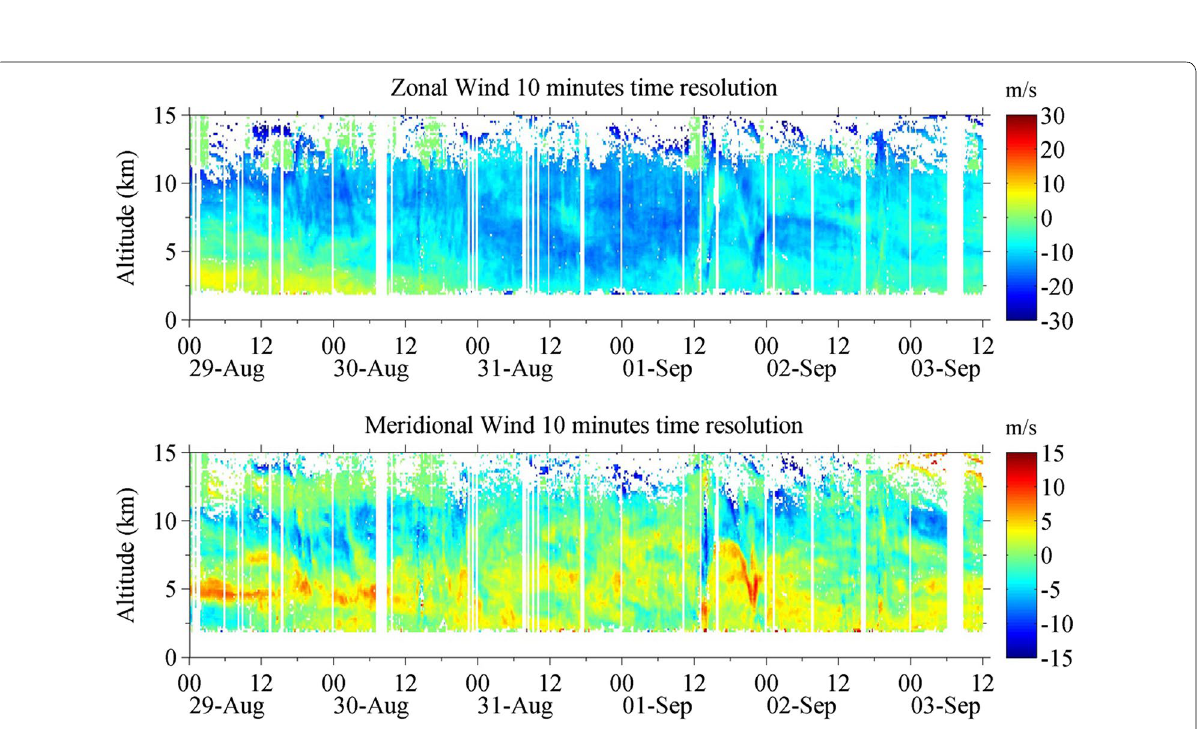
Fig. 19 Time and height variations of the eastward (top) and northward (bottom) wind velocity observed with the standard five-beam method with EAR from August 29 to September 3,